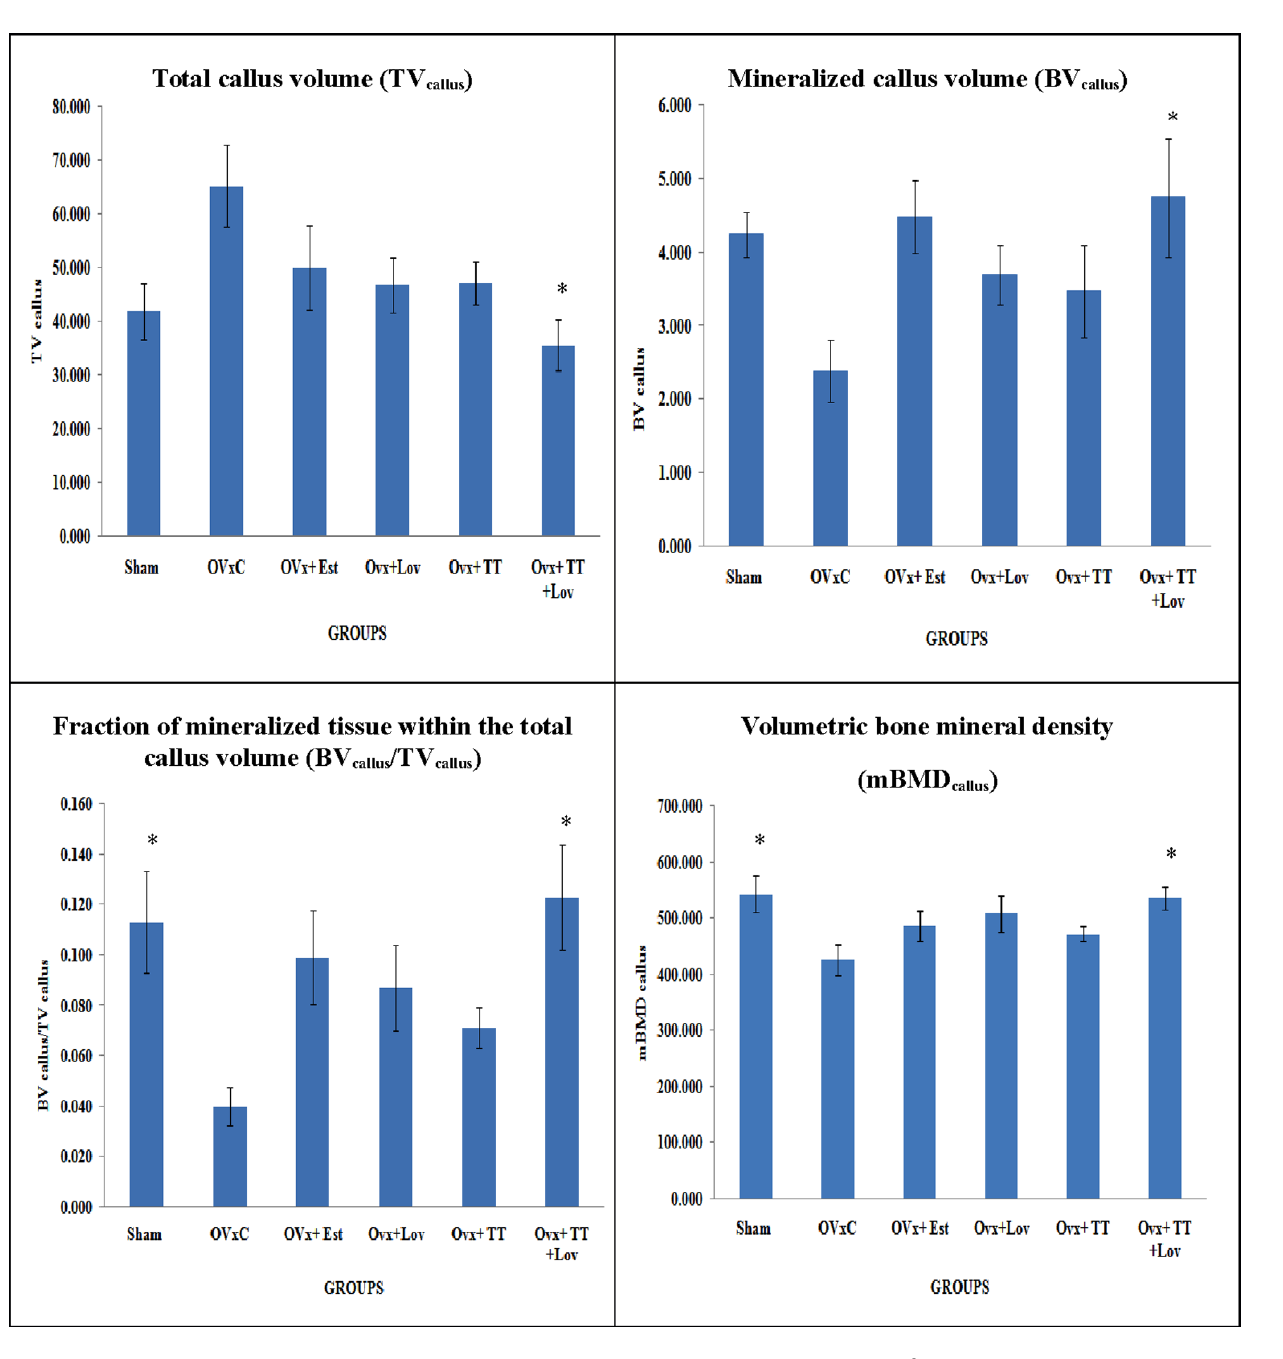
Fig. 4. 3-D structure of mineralized callus after undergoing global thresholding at 421 mgHA/cm 3 for micro-CT reconstruction. Sham:sham- operated group, OVxC:ovariectomized control group, OVx + Est:ovariectomized + Estrogen, OVx + Lov:ovariectomized + Lovastatin, OVx + TT:ovariectomized + Tocotrienol, OVx + TT + Lov:ovariectomized + Tocotrienol + Lovastatin.